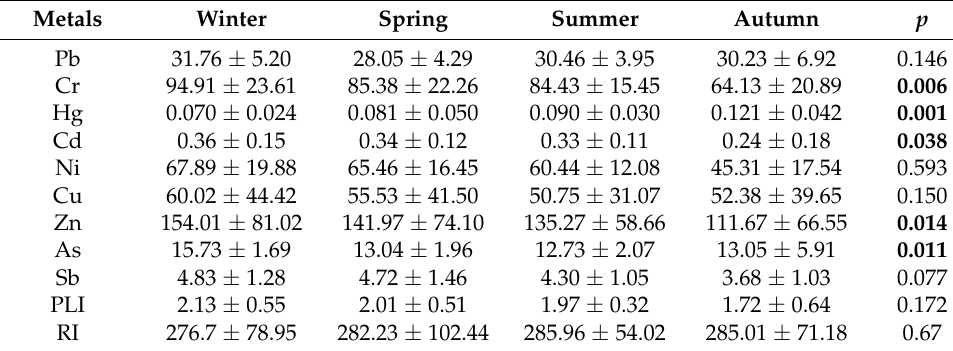
Table 1. The averages (unit: mg/kg) and standard deviation (SD) of heavy metal concentrations, PLI, and RI in different seasons. Significant p values are in